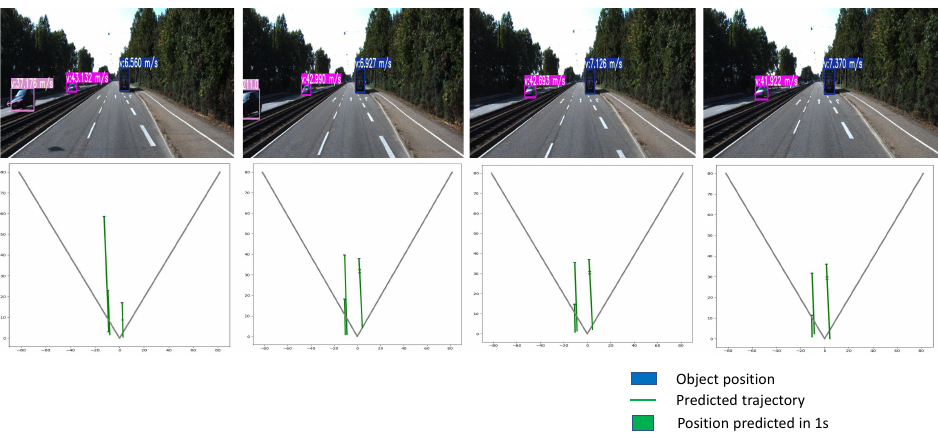
Figure 12. Tracking results over a sequence from the KITTI dataset. On top, four RGB frames coming from a road sequence acquired at different times with the corresponding tacking boxes of the moving objects and their speed values. On bottom, the maps shown are proposed by this work in order to generate a synthetic tool that allows simple yet comprehensive results overview of motions and distances of the tracked